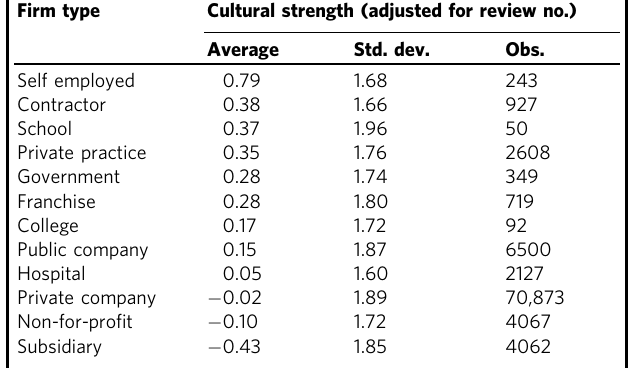
Table 6 Average cultural strength (computed on “ pros ” ) by fi rm type. Firm type Cultural strength (adjusted for review no.)